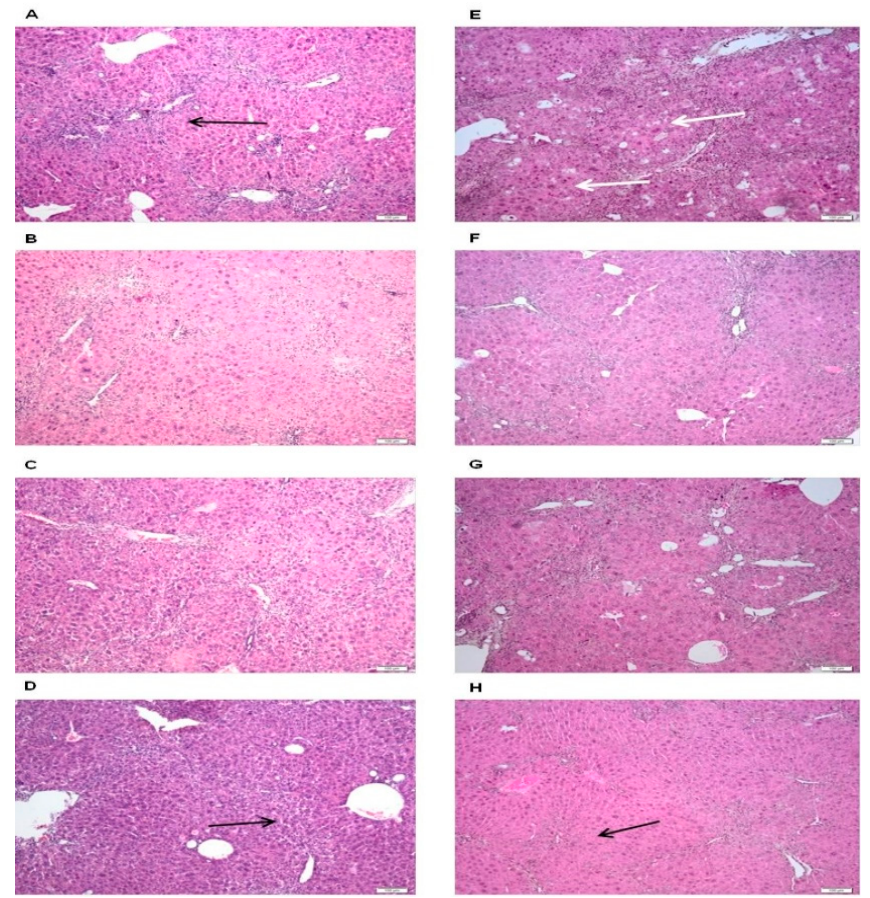
Figure 4. Effects of O. vulgare ssp. vulgare extract on the histologic aspect of the liver: ( A , E ) the negative control groups receiving only carbon tetrachloride (1 mL/b.w.) showed infiltrate around the portal spaces (black arrow), necrotic foci (white arrows); and the groups receiving therapy with the extract in a dose of: 1 mg/b.w., ( B , F ); 3.5 mg/b.w.; ( C , G ); and 7 mg/b.w. ( D , H ). The animals treated with the highest dose showed decreased fibrosis (black arrows). Duration: ( A – D ) four weeks; ( E – H ) six weeks. Hematoxylin and eosin stain; Bar, 100 µm.